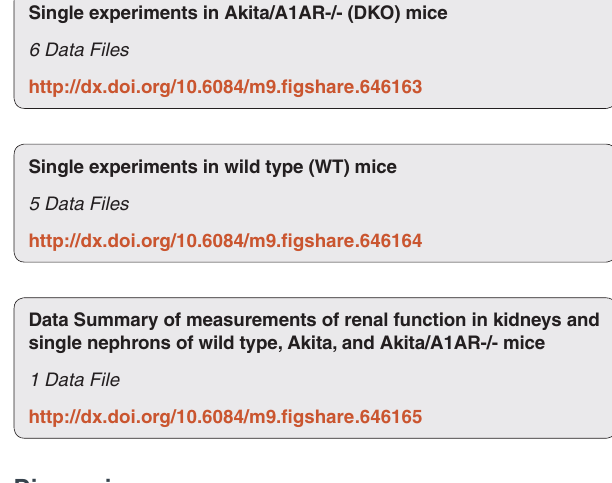
Figure 1. Measurements of single nephron filtration rate (SNGFR) and TF/Piothalamate ratios in wild type (WT), Akita, and Akita/ A1AR-/- double mutant mice (Ak/A1AR-/-). A : SNGFR in individual tubules; solid lines indicate mean values and broken lines are 95% confidence intervals. B : TF/Piothalamate ratios in individual tubules; solid lines are mean values and broken lines are 95% confidence intervals; numbers in brackets are numbers of mice/numbers of tubules.